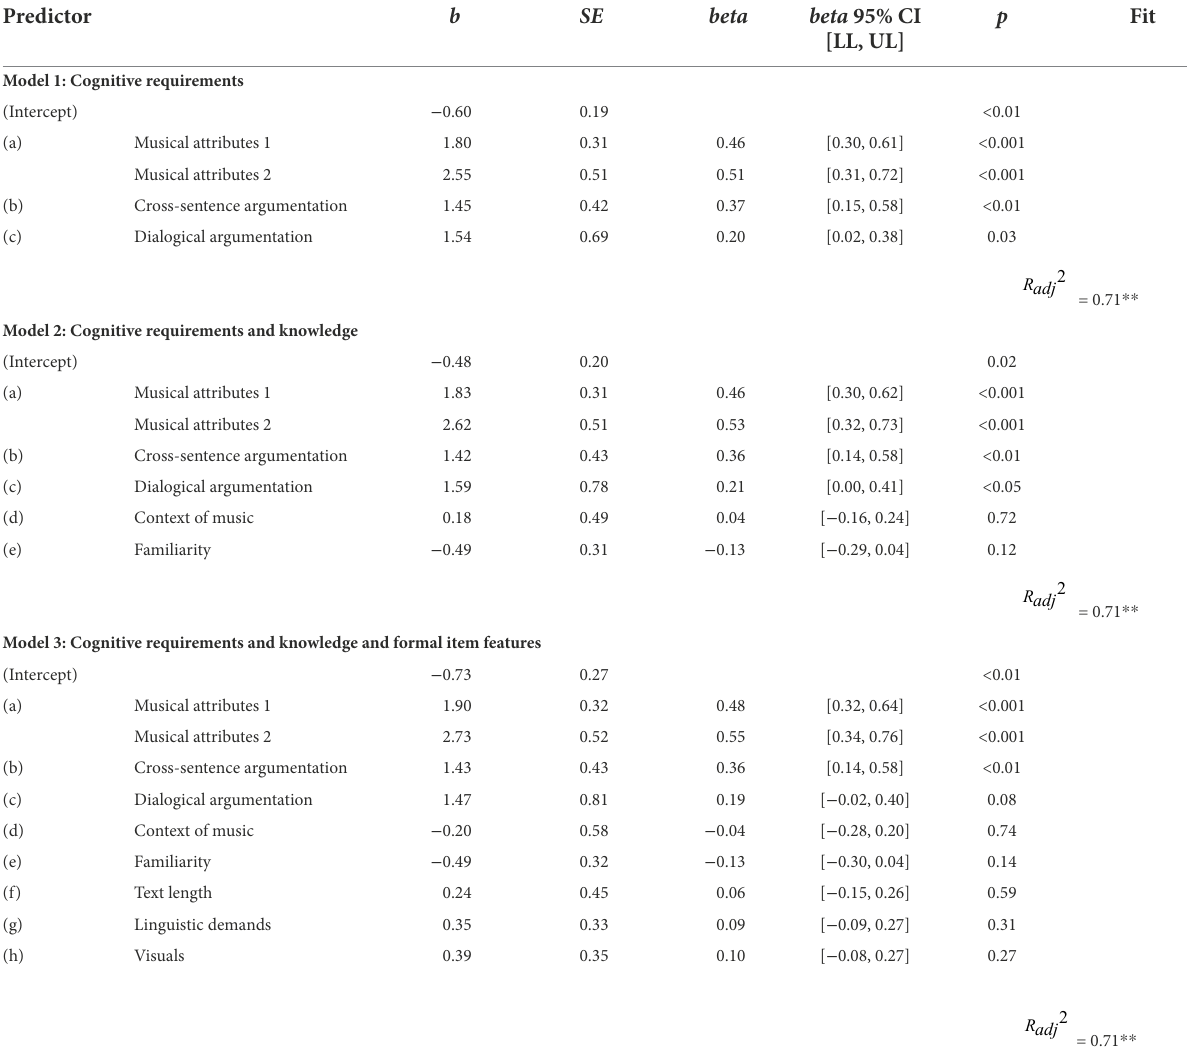
TABLE 7 Regression results with the criterion of item difficulty (thresholds).